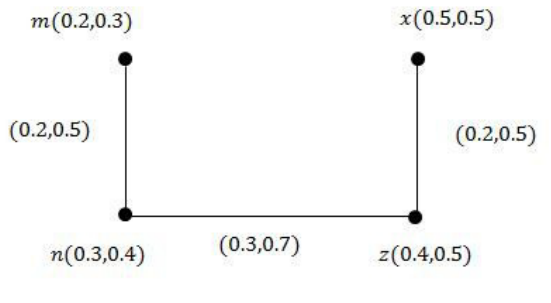
Figure 3. Highly irregular vague graph (HIVG) ( G